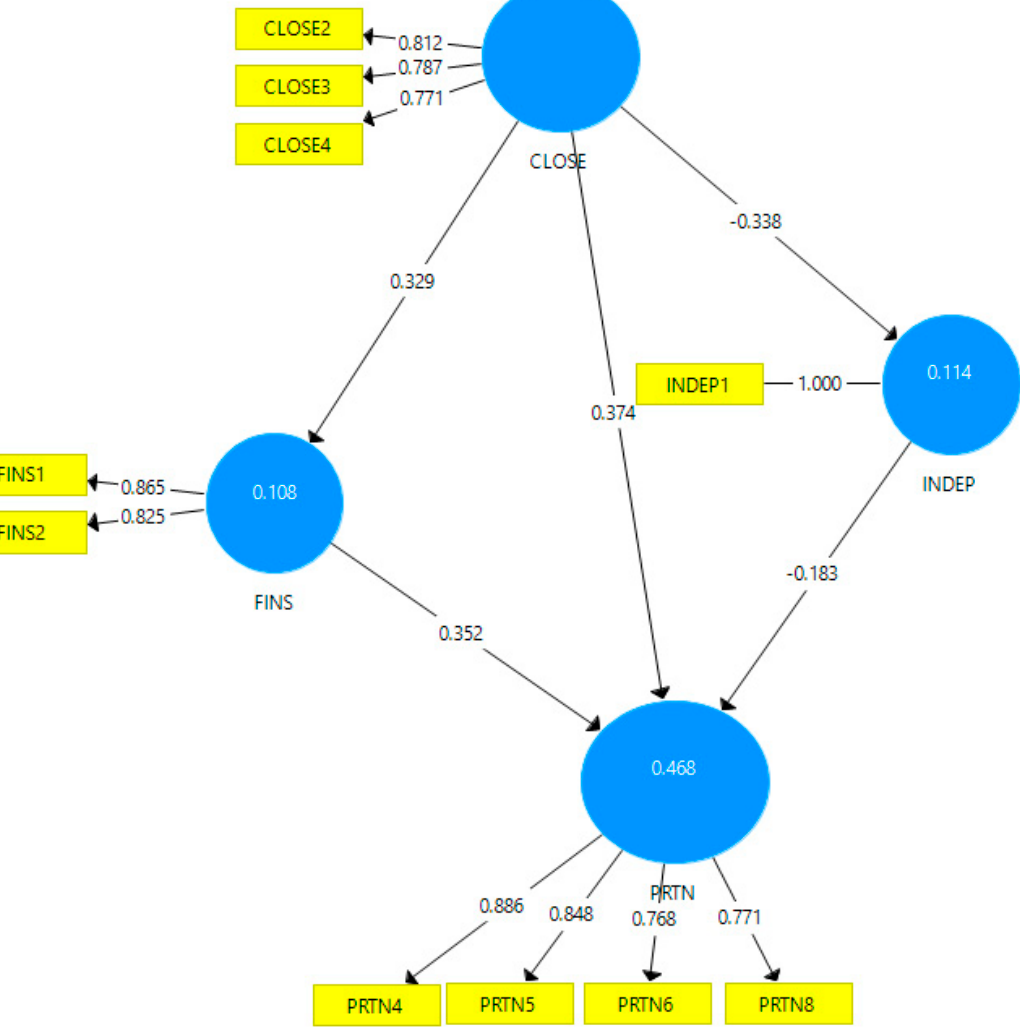
Figure 2. Path coefficients and outer loadings of the model. Source: Developed with SmartPLS v.3 software.